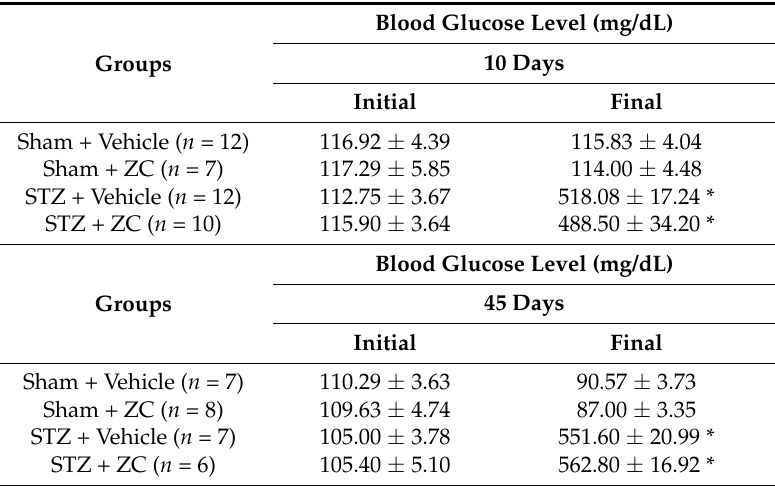
Table 2. Effect of ZC on change in blood glucose level of sham and STZ-induced diabetic rats. Values are means ± SE, n = 6–12 from each group; * p < 0.05, versus sham group.